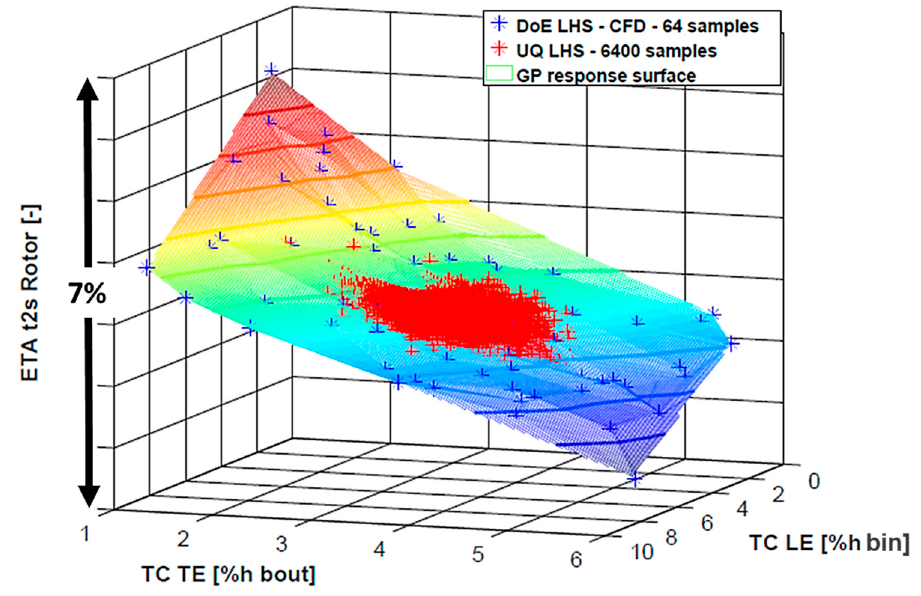
Figure 7. SB-UQ: rotor efficiency response surface and samples.